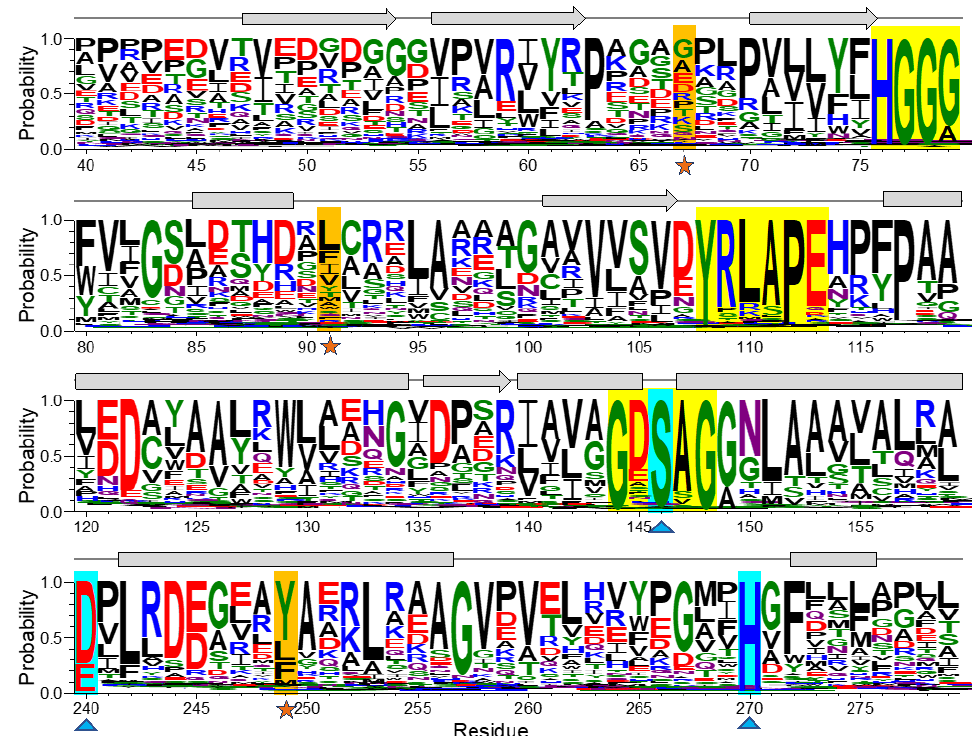
Figure 2. Graphical representation of sequence conservation of partial EstJ6. The sequence logo was generated by the WebLogo3 server after sequence alignment. The mutated sites, triads, and three conservative motifs are highlighted in orange, cyan, and yellow, respectively. The size of the logos represents the relative frequency of each